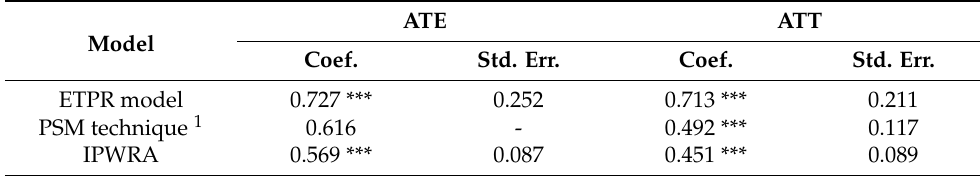
Table 5. Treatment effects of socialized service use on SAP